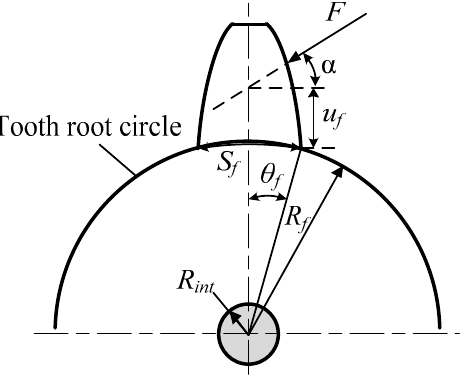
Figure 5. The instructions of μ f and S f .